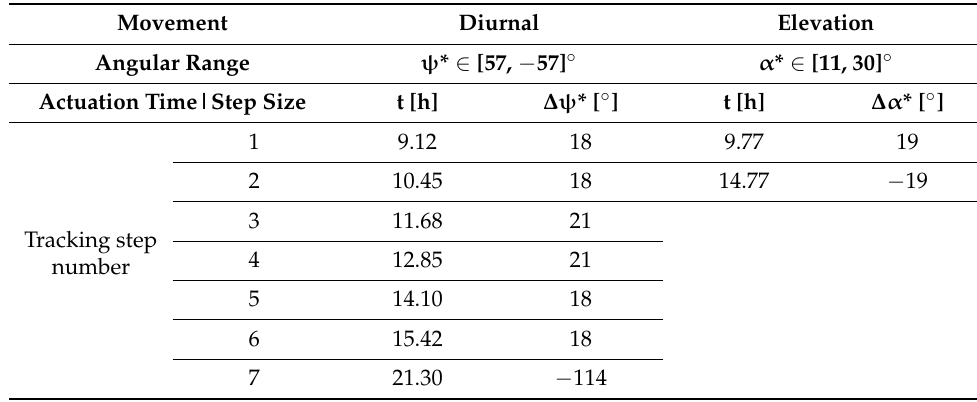
Table 2. Tracking program “1”/“13”.